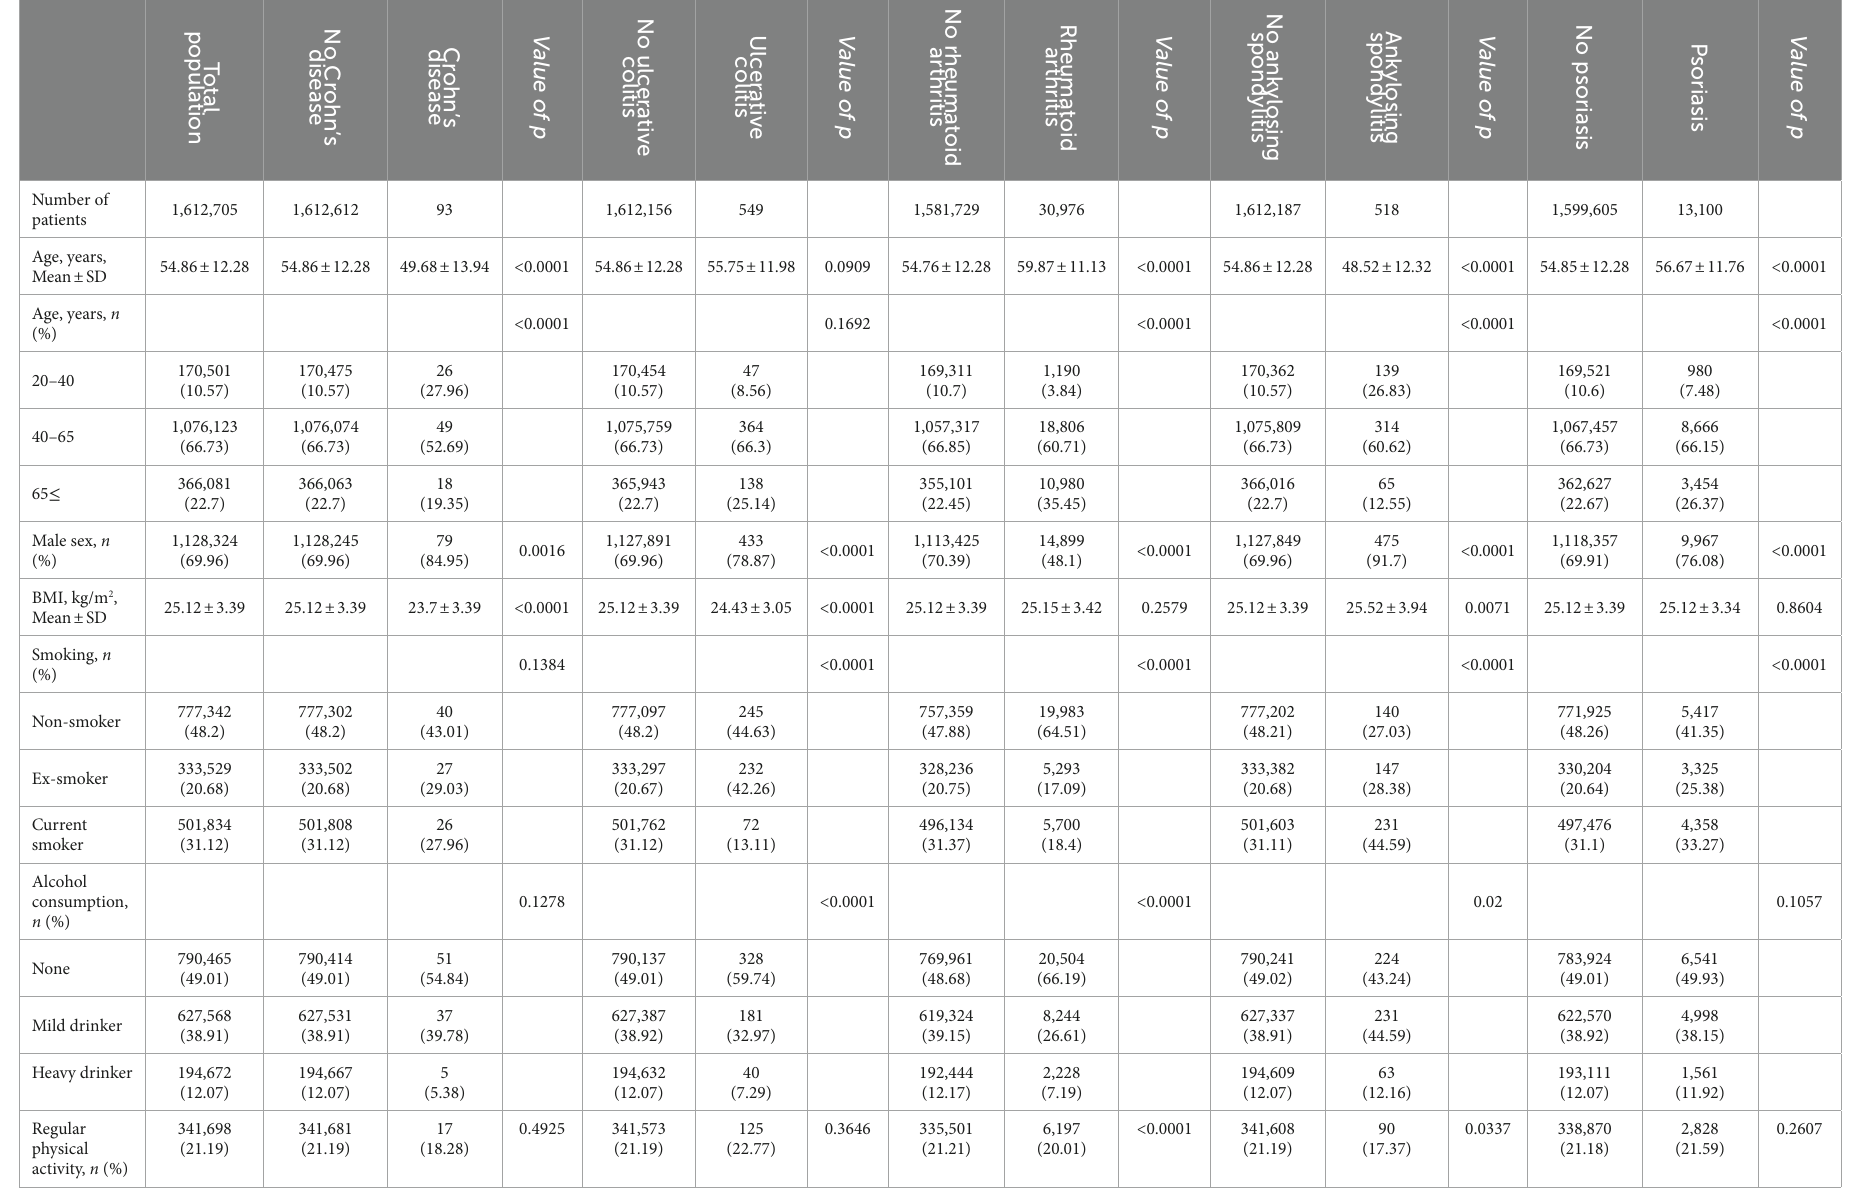
TABLE 1 Baseline characteristics of the patients with type 2 diabetes according to the presence of immune-mediated inflammatory